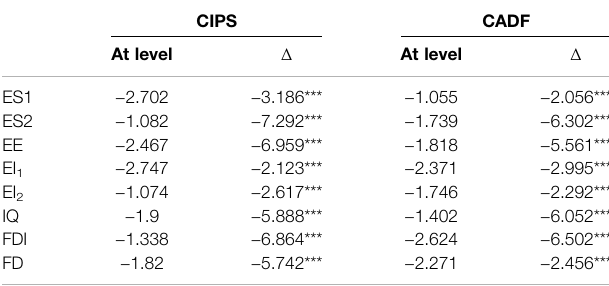
TABLE 4 | Panel unit root test results.